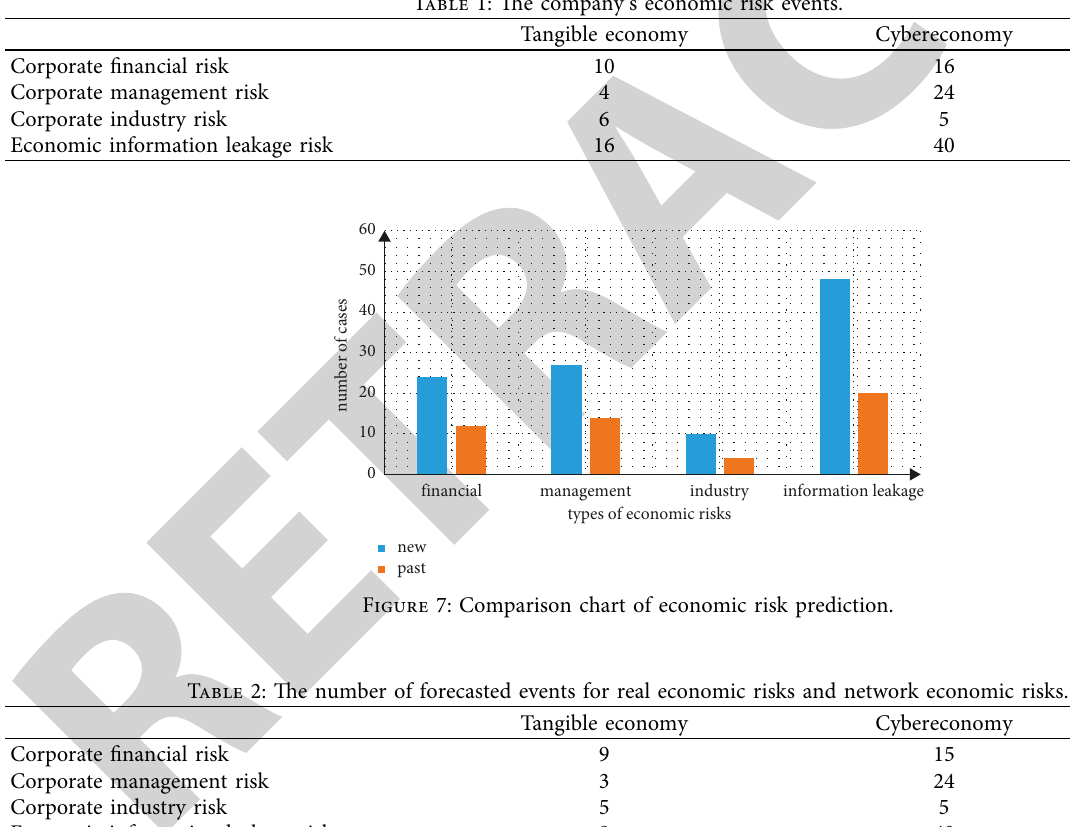
Figure 6: The newly constructed big data platform. Table 1: The company’s economic risk events.